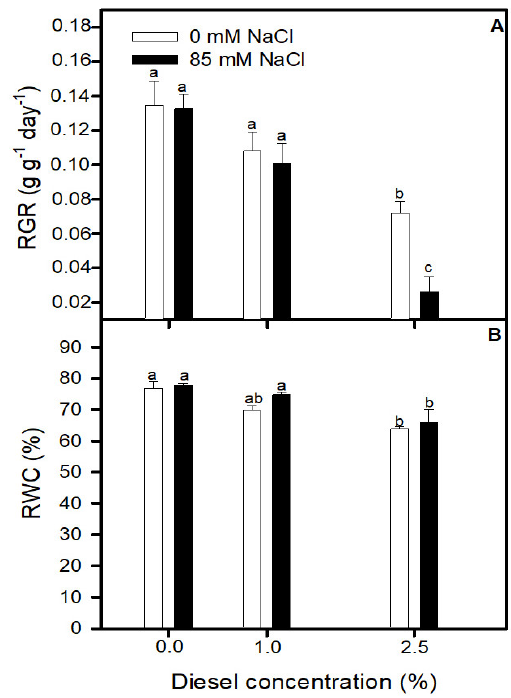
Figure 1. Relative growth rate (RGR) ( A ), and total relative water content (WC) ( B ) of Juncus acutus in response to treatment with a range of diesel concentrations at 0 and 85.5 mM NaCl for 20 d. Values represent mean ± SE, n = 10. Different letters indicate means that are significantly different from each other (LSD test, p < 0.05).